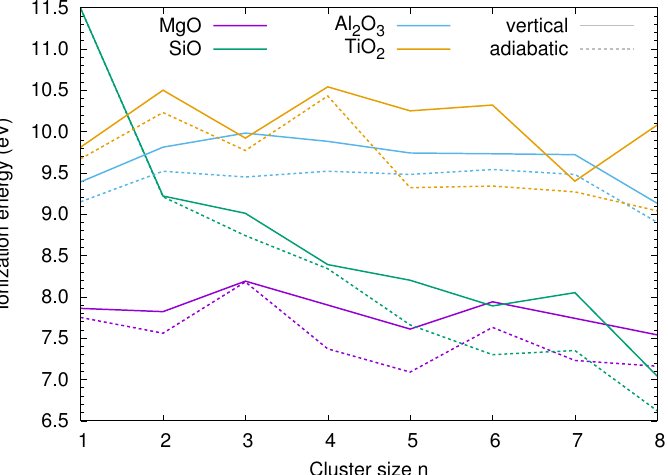
Figure 1. The vertical (straight lines) and adiabatic (dashed lines) ionization energies (in eV) of the metal oxide clusters as a function of cluster size